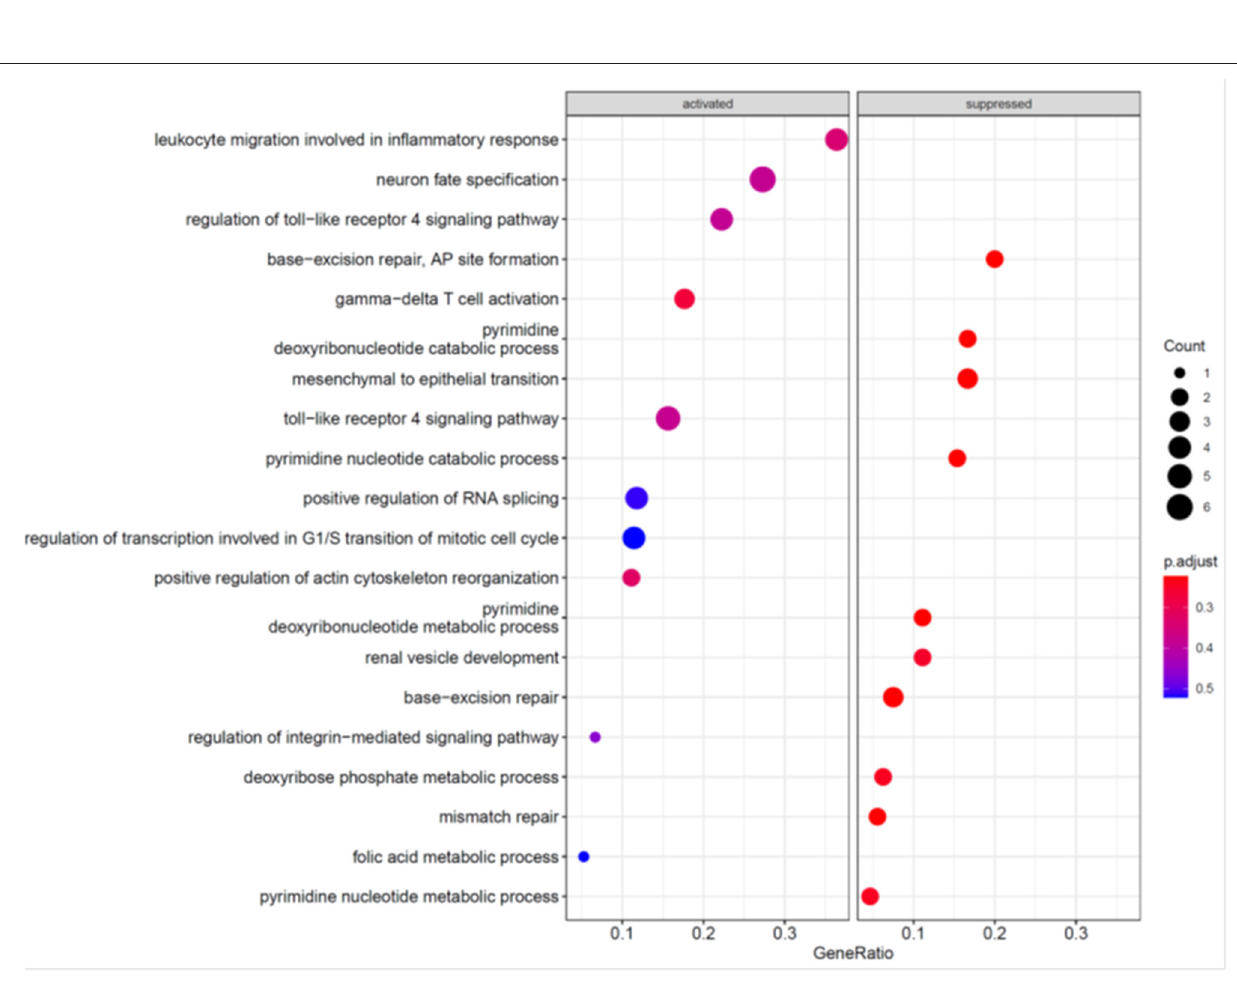
Frontiers in Medicine |